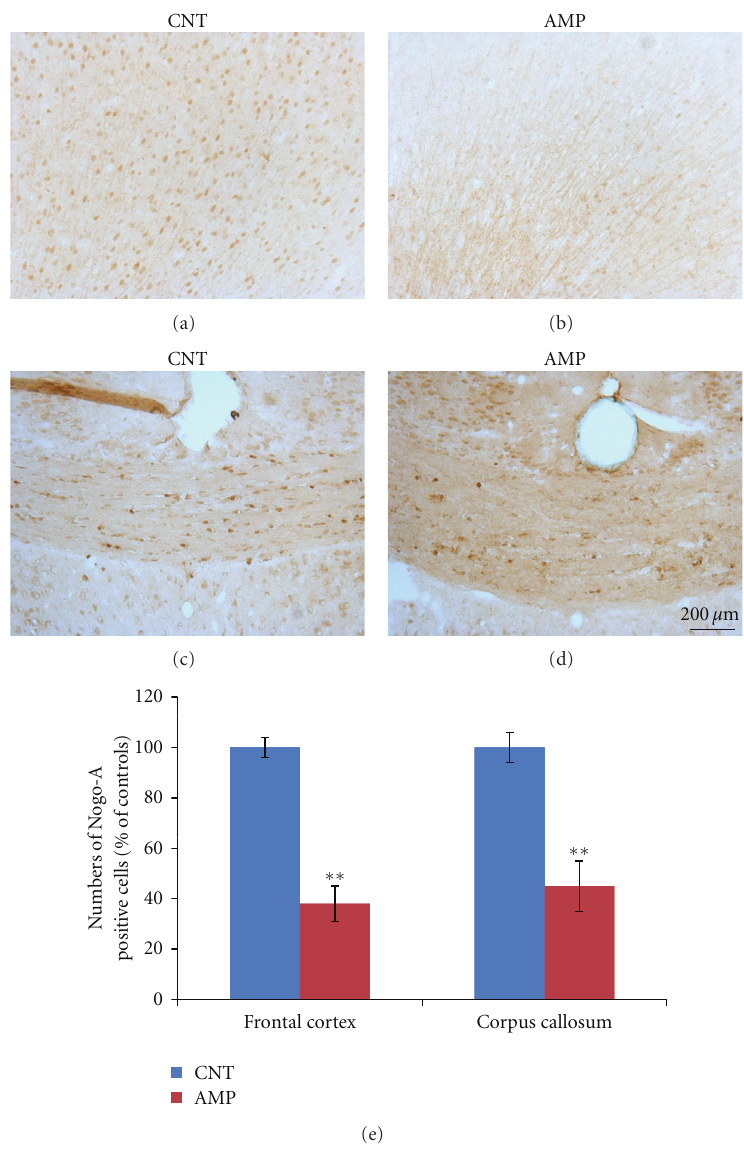
Figure 4: AMP reduced the numbers of Nogo-A positive cells in cerebral cortex and corpus callosum. After treating with d-AMP or a same volume of saline for 21 days and subjected to behavioral tests, mice were sacrificed and their brains were processed for immunohistochemical staining. The numbers of Nogo-A positive cells in cerebral cortex and corpus callosum were counted. All AMP-treated mice had decreased Nogo-A cells than the average of CNT group. Representative photographs were presented and labeled. Quantitative data were statistically analyzed and presented in a bar chart. Data were expressed as means ± SEM. Comparisons were made between CNT and AMP groups. ∗∗ P < 0 . 01.